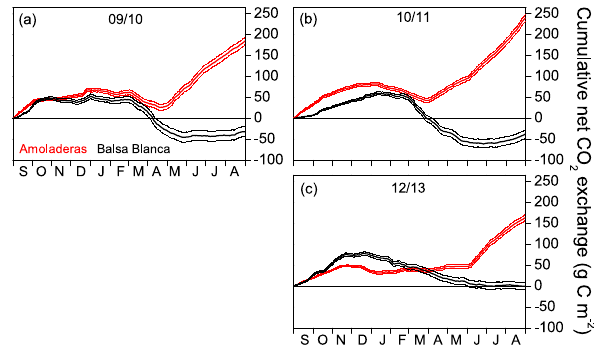
Figure 3. Cumulative annual net CO 2 exchange over the 3 hydro- logical years without long periods of missing data at both experi- mental sites, Amoladeras (red lines) and Balsa Blanca (black lines). Negative values denote net carbon uptake, while positive values de- note net carbon release. Thin lines indicate uncertainty derived from the gap-filling procedure.